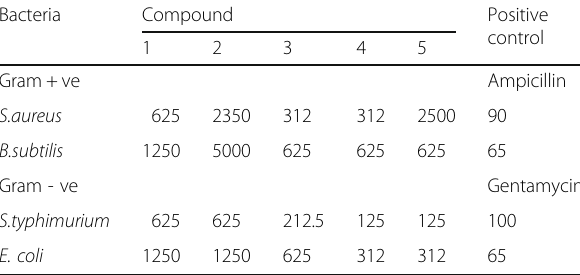
Table 3 Minimum inhibitory concentration (MIC) as μ g/mL for 1 – 5